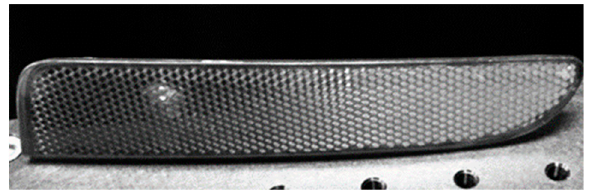
Figure 6. The commercial SuperPin curved reflex reflector.